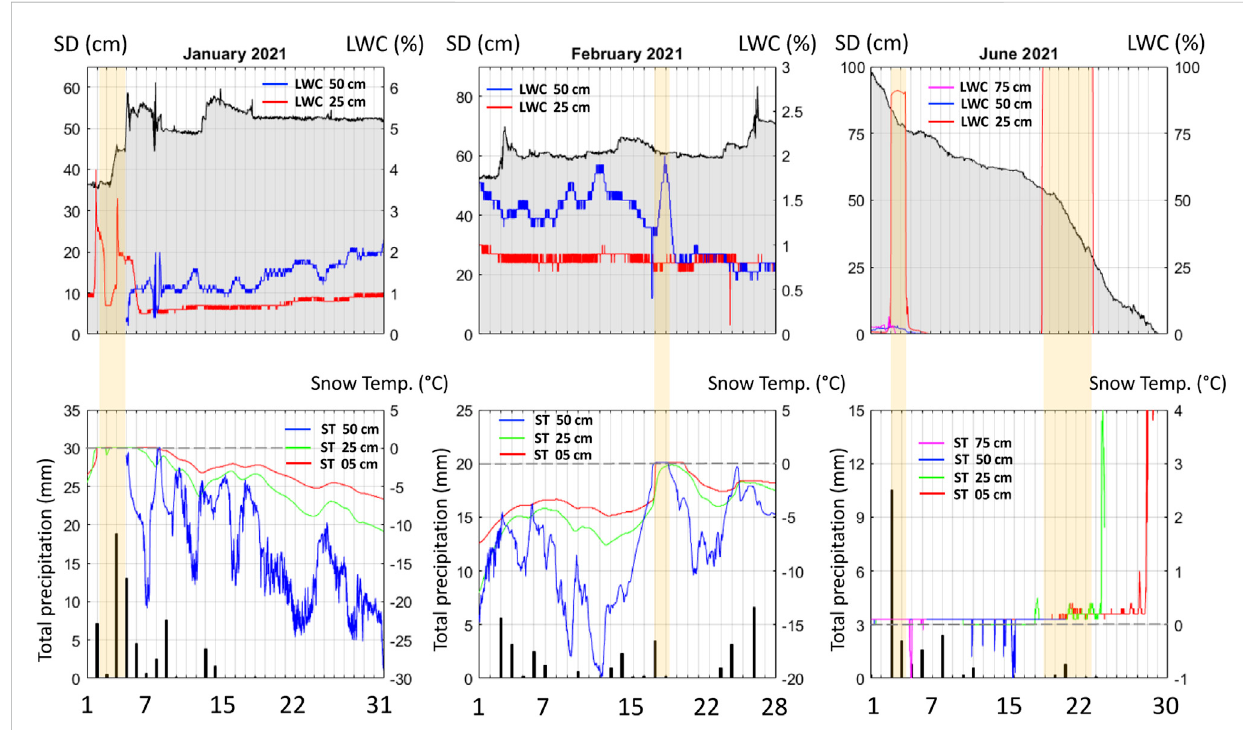
Snow height (upper panels), snow temperature (middle panels) and LWC (lower panels) in January, February, and June 2021. Yellow bands indicate the warming events associated with ROS and enhanced seasonal melting (late